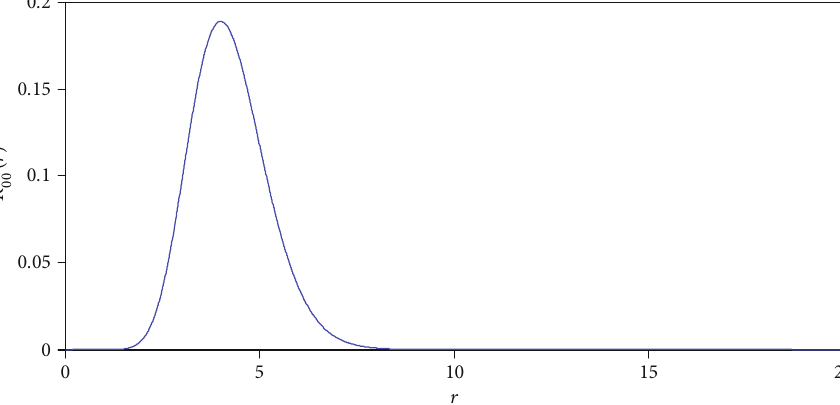
Figure 5: Wave function ð eV Þ in terms of r ð A 0 Þ of the Eckart plus Hulthen potential for n = l = 0 , α = 0 : 05 , and V y = μ = 1